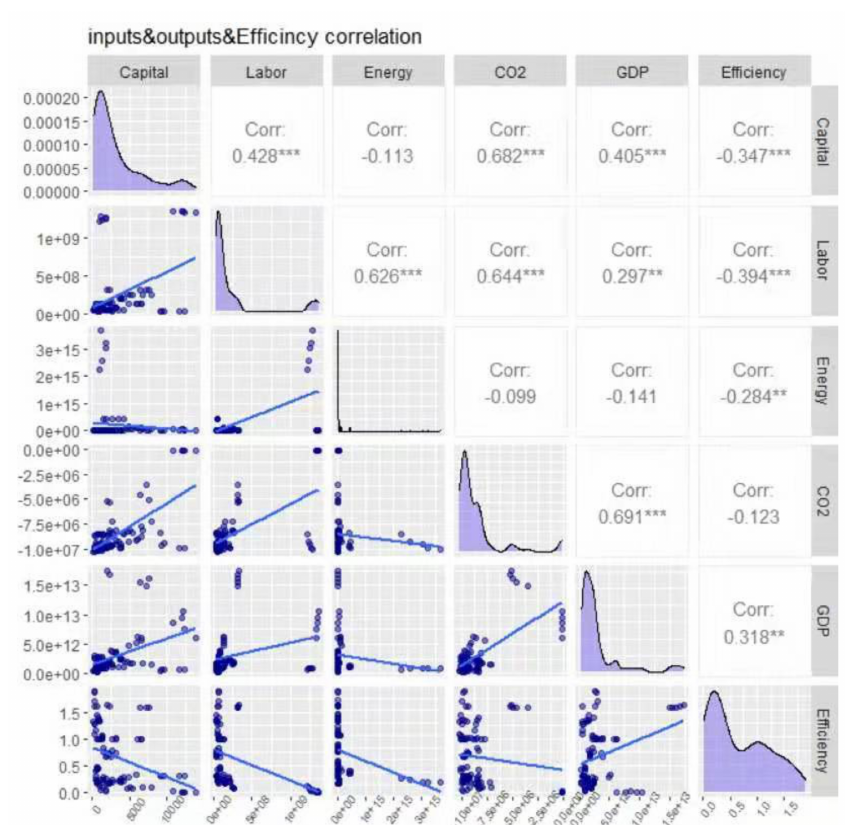
Figure 4. Correlation coefficient between input, output, and